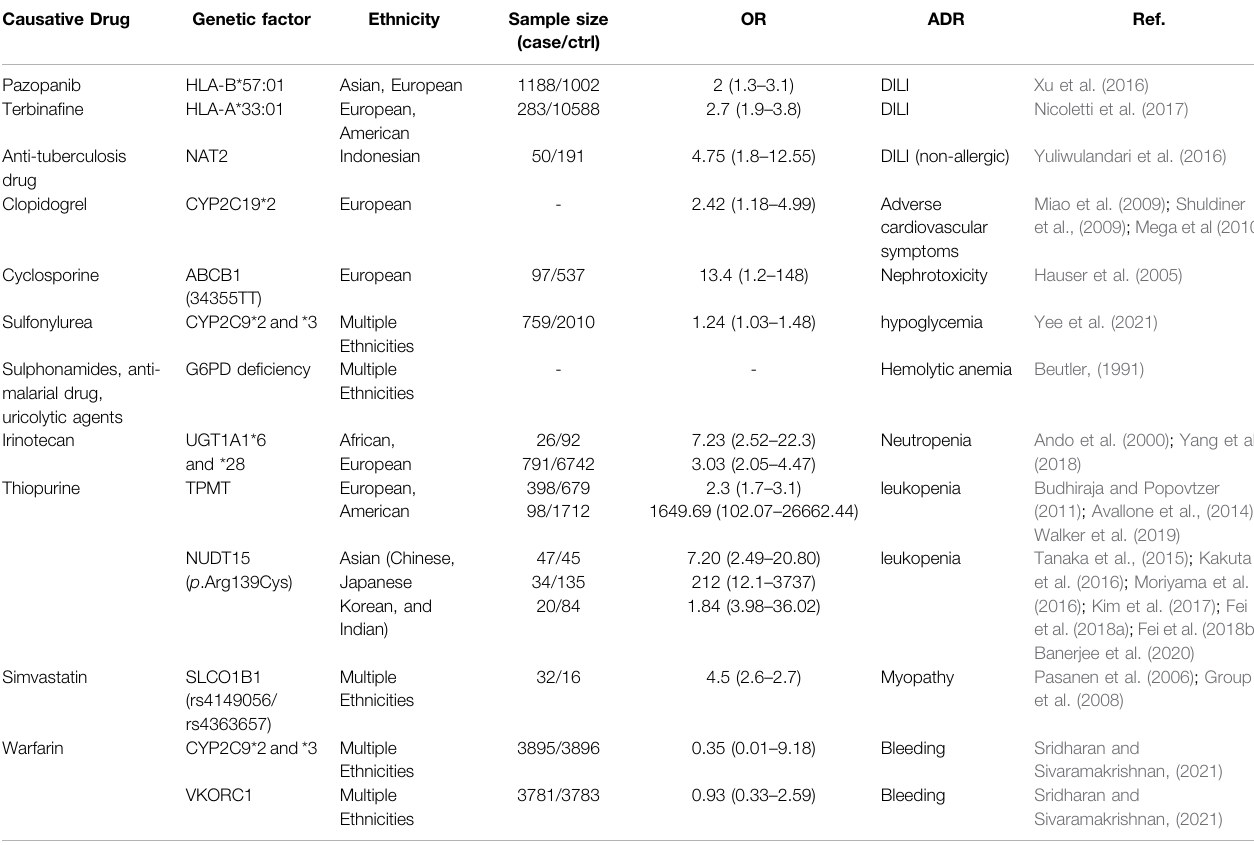
TABLE 1 | ( Continued ) Genetic associations with severe ADR in HLA, TCR, drug metabolism enzymes, and drug